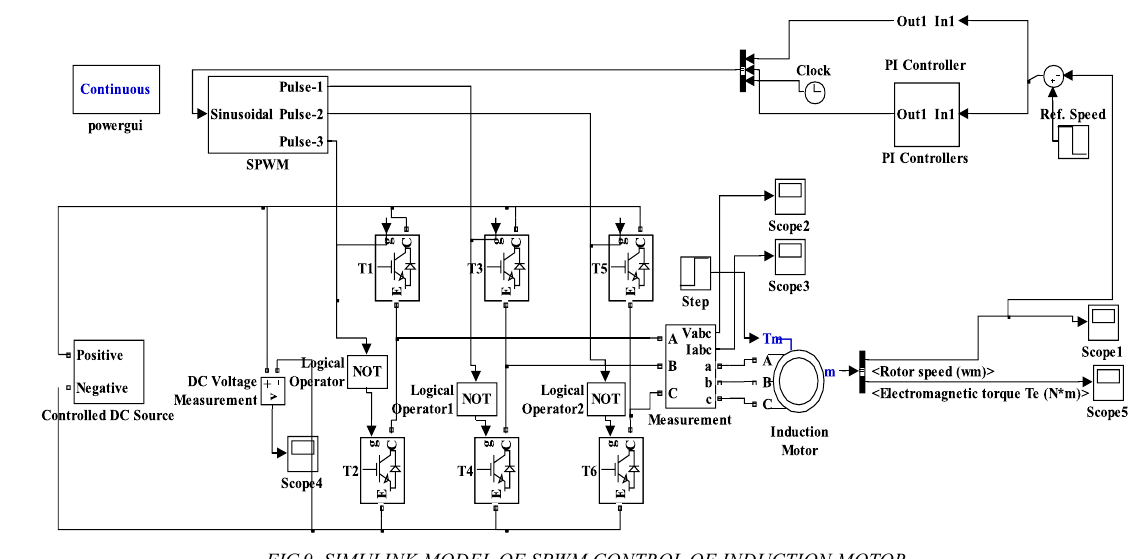
FIG.8. SIMULINK MODEL OF SVPWM CONTROL OF INDUCTION MOTOR